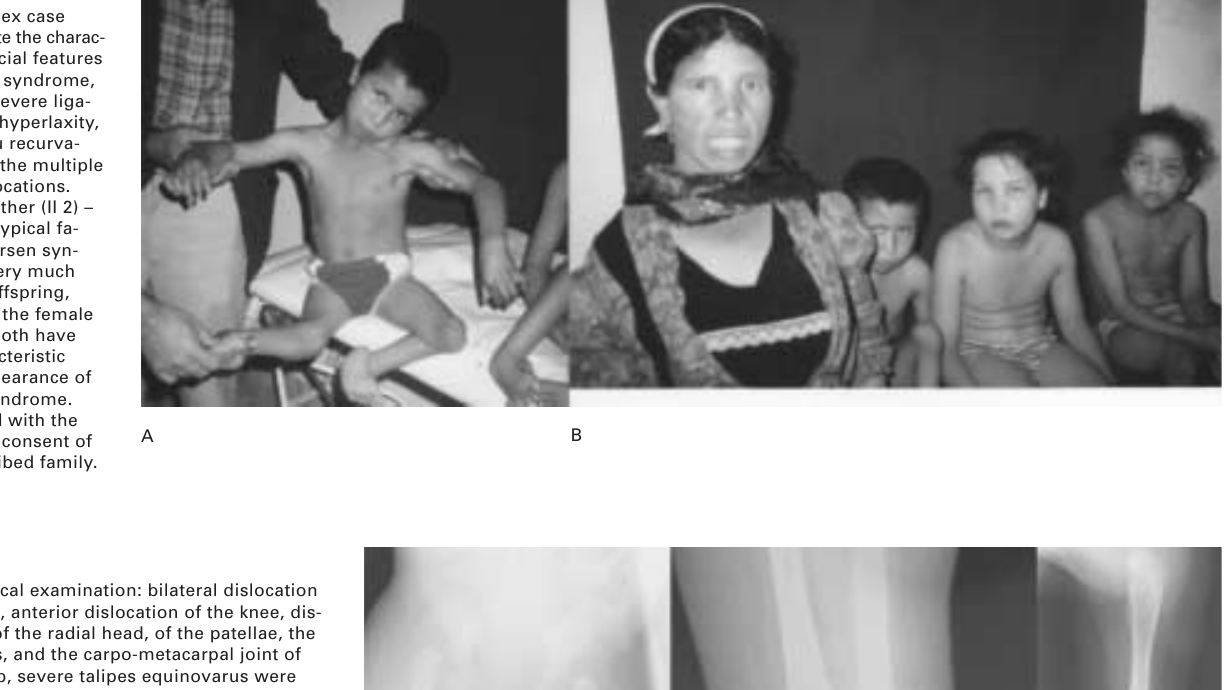
Radiological examination: bilateral dislocation of the hip, anterior dislocation of the knee, dis- location of the radial head, of the patellae, the shoulders, and the carpo-metacarpal joint of the thumb, severe talipes equinovarus were encountered in the three siblings, thoracic scol- iosis secondary to congenital flattening of the thoracic vertebrae, and cervical vertebral flat- tening particularly of the 3 rd , 4 th 5 th vertebrae. Advanced bone age in the carpals, and sublux- ation of the carpo-metacarpal joint. A: X rays of the index case (III 3) note the mul- tiple dislocations; bilateral hip dislocation, bi- lateral anterior dislocation of the tibia on the femur, the fibulae are hypoplastic bilaterally, the patellae are dislocated laterally, and bilat- eral talipes equinovarus. B: X ray hand at age two months note: advanced bone age in the carpals and subluxa- tion of the carpo-metacarpal joint of the thumb. C: X ray of the upper limb: note anterior dis- location of the of the radial head, with total disruption of both the radio-capitellar and humero-ulnar joints, this may be partly due to dysplasia of the distal humerus and condylar